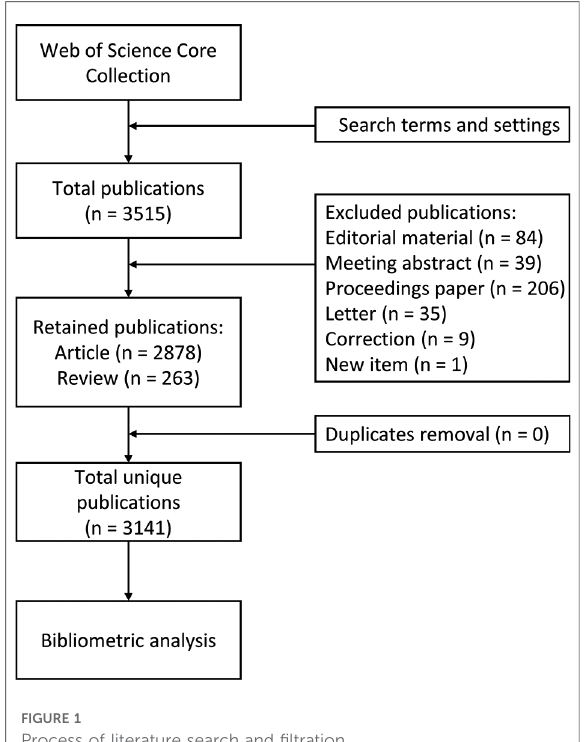
FIGURE 1 Process of literature search and fi